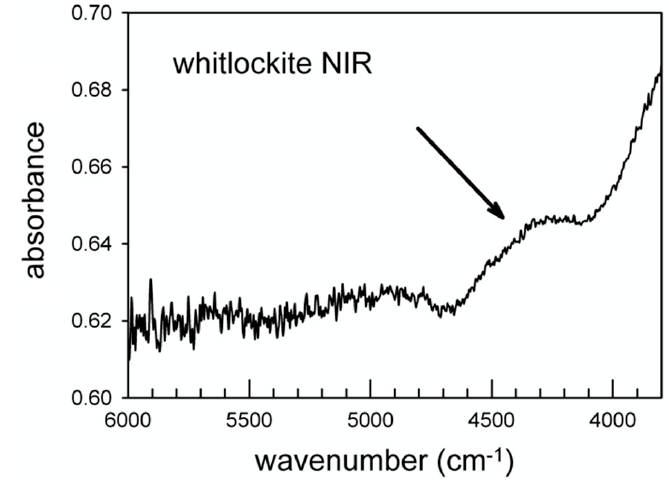
Figure 9. Single-crystal NIR spectrum of